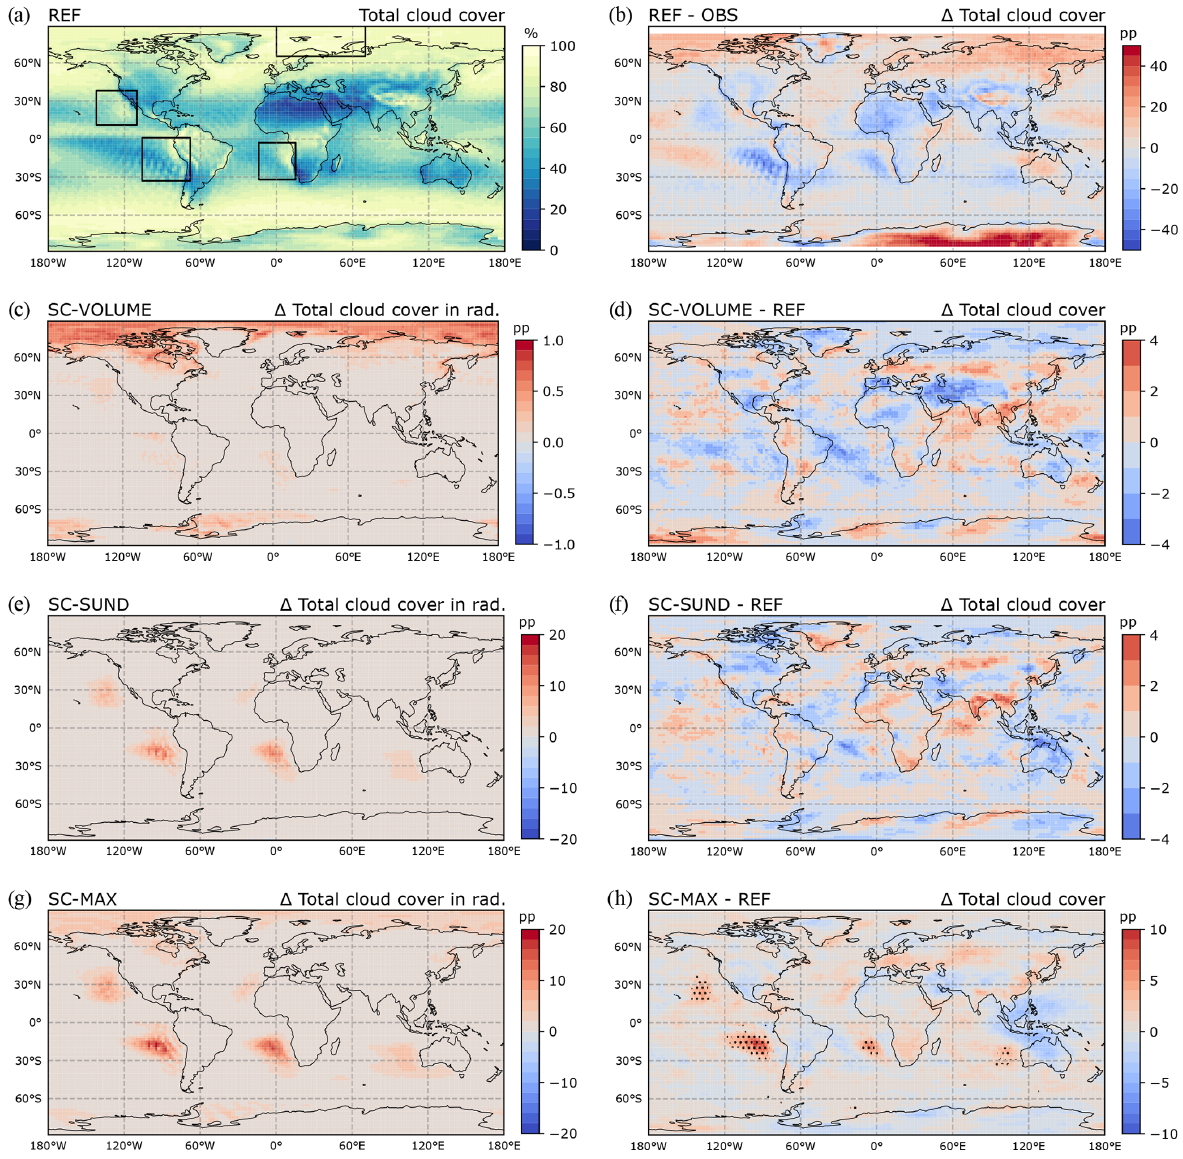
Figure 6. Total cloud cover results from 15-year free global climate simulations. The top row shows the reference results (REF) for (a) total cloud cover and (b) the difference with CALIPSO climatology. The remaining panels (c–h) show the results with SC-VOLUME, SC-SUND, and SC-MAX: the left column displays the total cloud cover increase exerted in the radiation routine, and the right column displays the change in the simulated total cloud cover compared with REF (stippling indicates statistically significant differences at the 95% significance level; the false discovery rate is controlled following Wilks, 2016). The regions highlighted in panel (a) are defined as follows: NAM (38–11 ◦